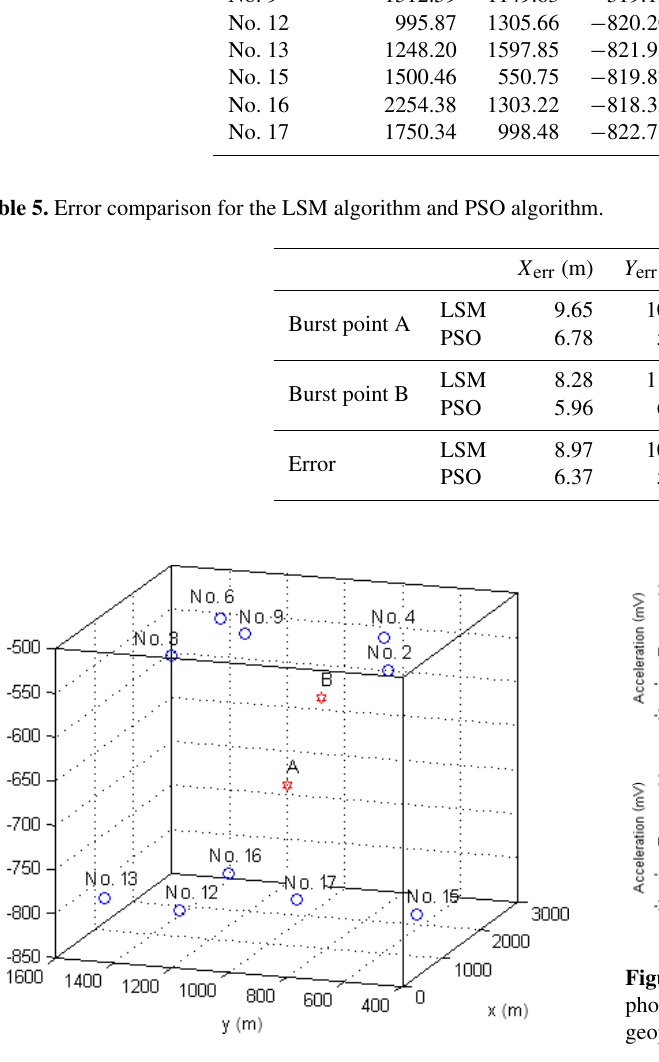
Figure 5. Schematic diagram of the relative position of the 10 geo- phones and the two burst points.